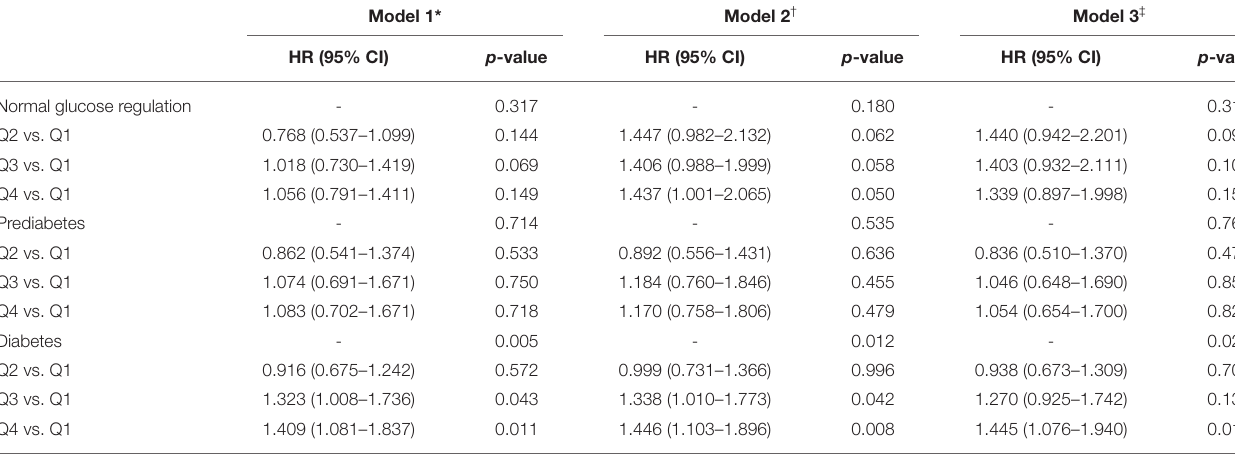
TABLE 5 | Predictive performance of DB under different conditions of glucose metabolism regulation.